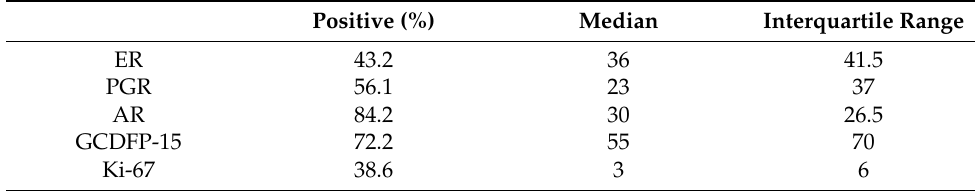
Table 2. Epithelial expression of